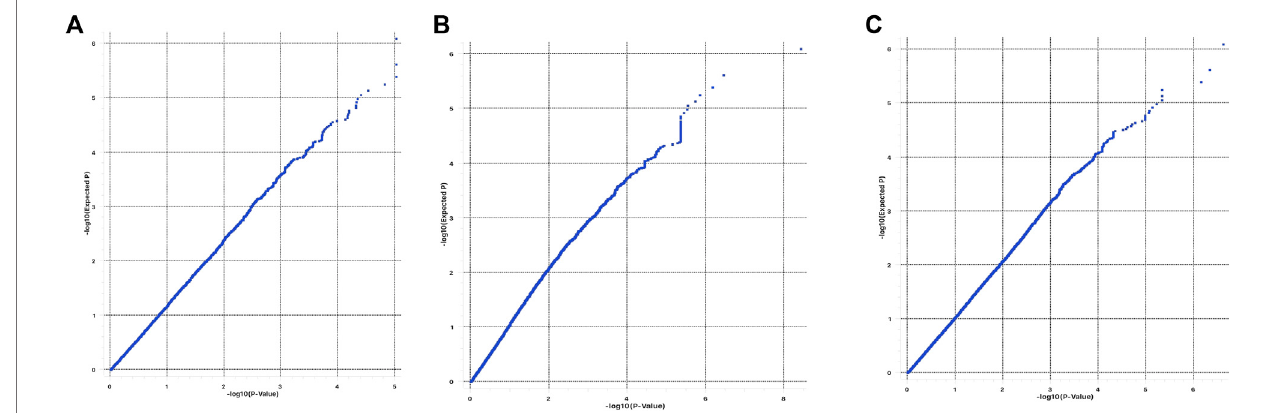
FIGURE 5 | Manhattan plots based on GWAS of (A) base coat colour; (B) Forehead stripe and (C) coloursided phenotypes.